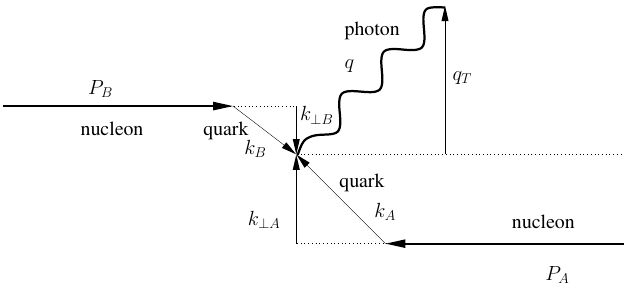
Figure 2 . Diagram describing the relevant momenta involved in a Drell-Yan event: two partons from two hadrons collide. They have transverse momenta k ? A and k ? B (not measured). They produce a virtual photon with (measured) transverse momentum q T = k ? A + k ? B with respect to the hadron collision